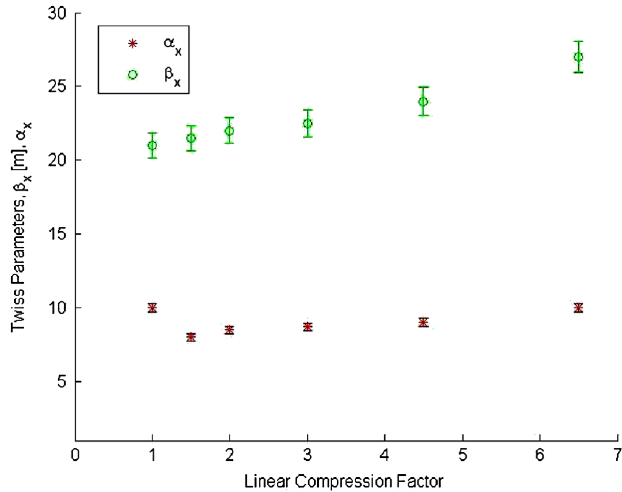
in x FIG. 8. Beam horizontal Twiss parameters (green circle , red star marker for (cid:10) ) measured as a function marker for (cid:4) x x of the compression factor. This is varied by keeping BC1 at the fixed bending angle of 85 mrad and by varying the L1 rf phase.